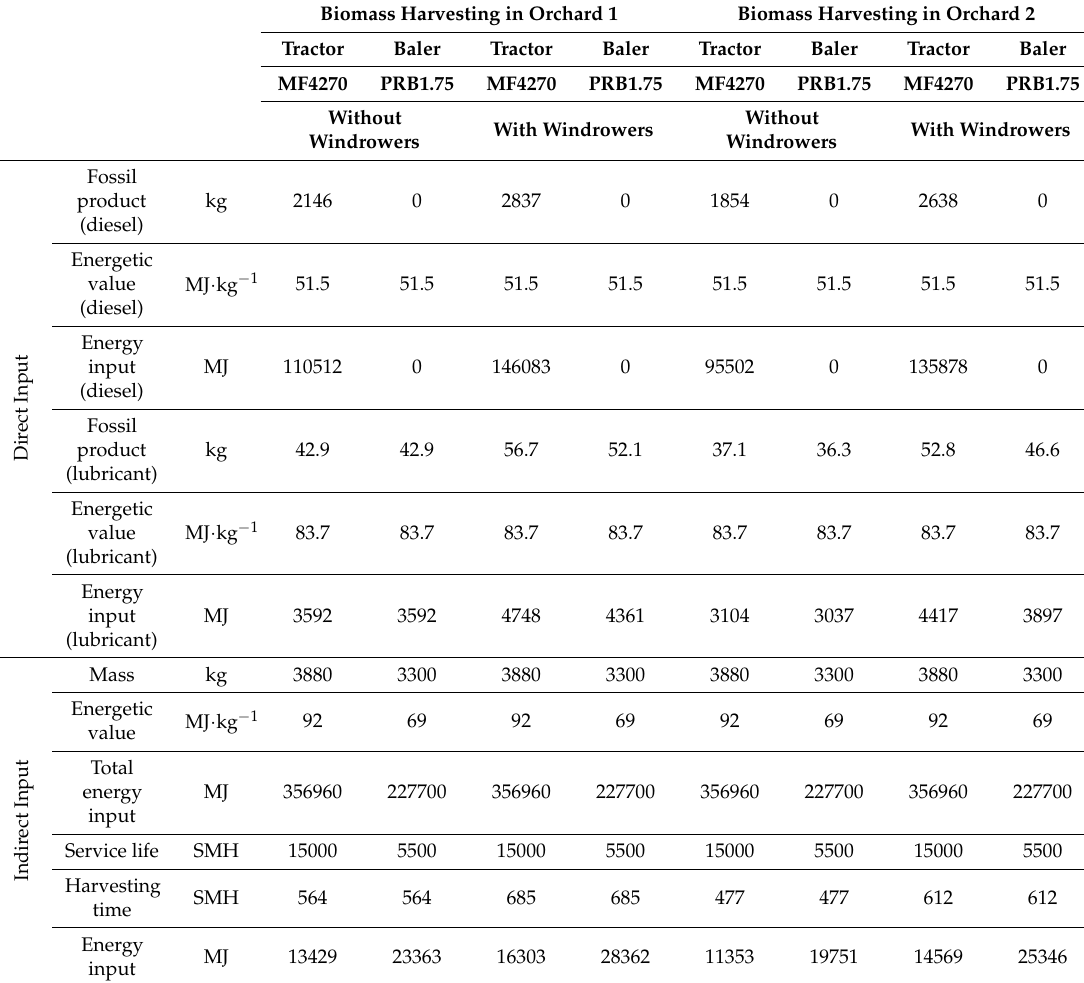
Table 3. Direct and indirect energetic input for evaluated pruned biomass harvesting variants in the apple orchards (assumed operated orchard area 400 ha).